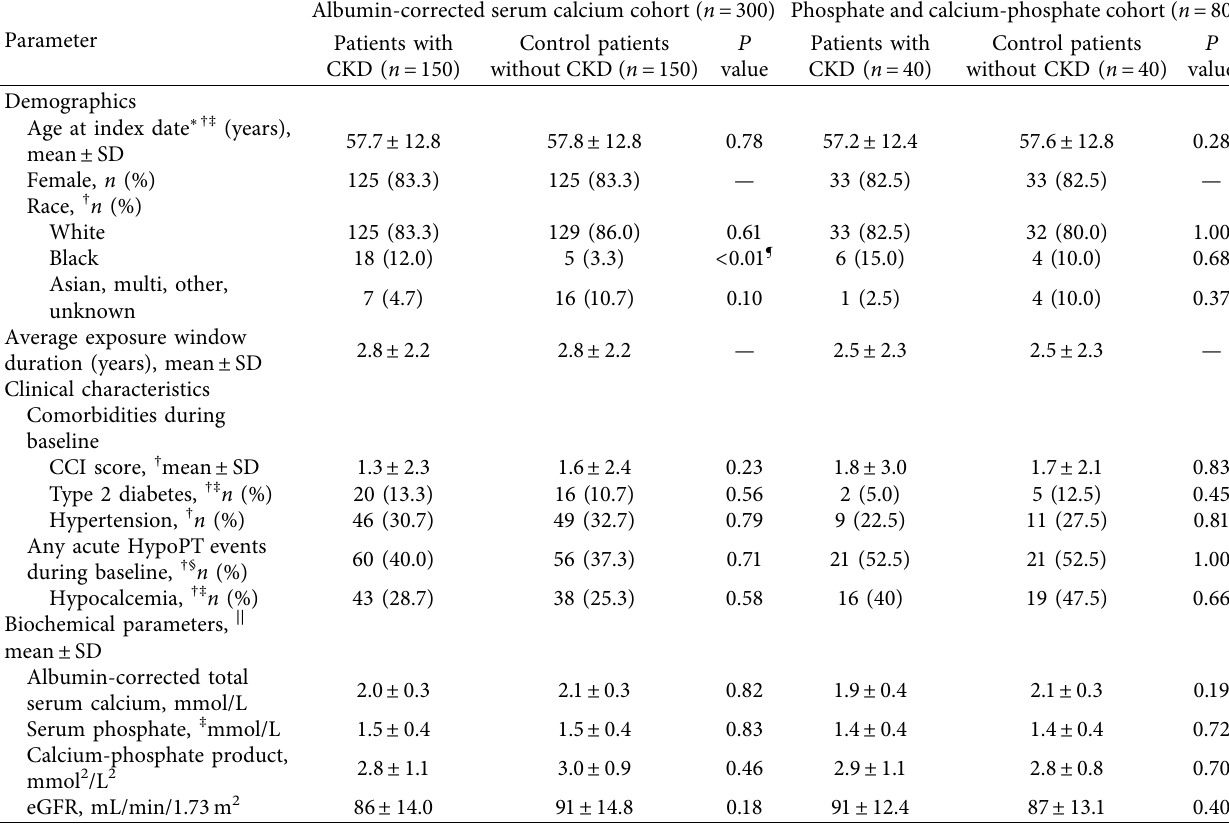
Table 1: Demographic, clinical characteristics, and biochemical parameter levels at the baseline in patients with chronic hypoparathy- roidism and CKD and matched patient